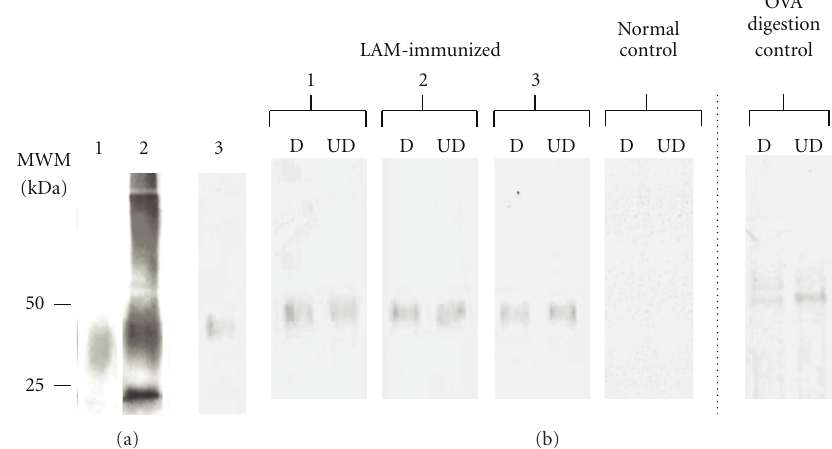
Figure 2: (a) Characterization of LAM extract by SDS-PAGE (lane 1: purified LAM of M. tuberculosis , lane 2: LAM extract, both silver-stained for carbohydrate detection) and immunoblot. (lane 3: LAM extract reactivity assessed against one representative serum from the infected control group). (b) Immunoblot of bovine sera reactivity against LAM extract. Left side of the dotted line: LAM extract was run as antigen. D and UD indicate protein-digested or undigested antigen. 1, 2 and 3 show results of three representative sera from LAM-immunized group. Normal control shows results representative for sera in that group. Right side of the dotted line: ovalbumin (OVA) was run as antigen and reactivity assessed against serum of an OVA-immunized bovine, as a positive control of protein digestion. MWM: molecular weight